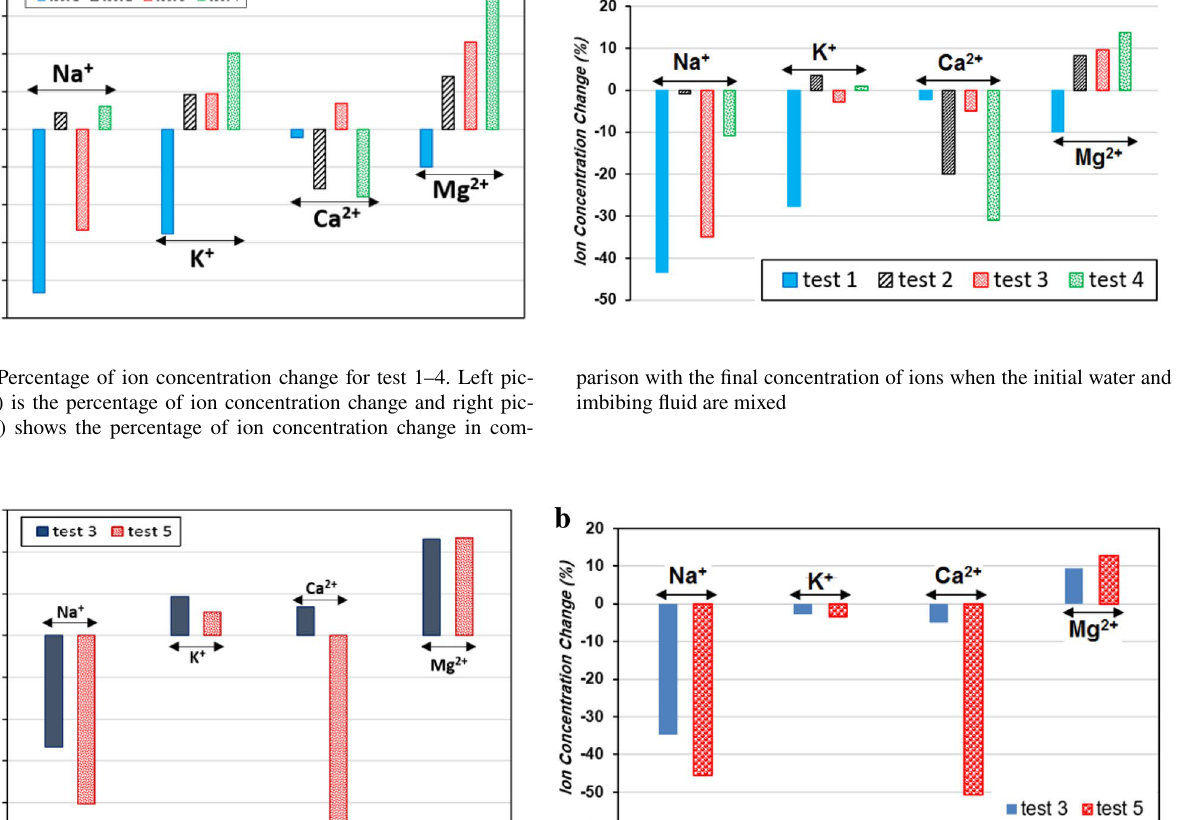
picture ( b ) shows the percentage of ion concentration change in com- parison with the final concentration of ions when the initial water and imbibing fluid are